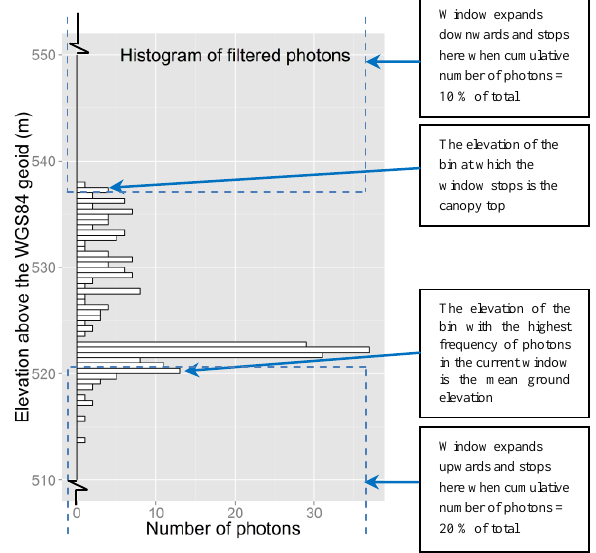
Figure 3. Diagrammatic representation of the height calculation algorithm (an example of a 25 m block from transect